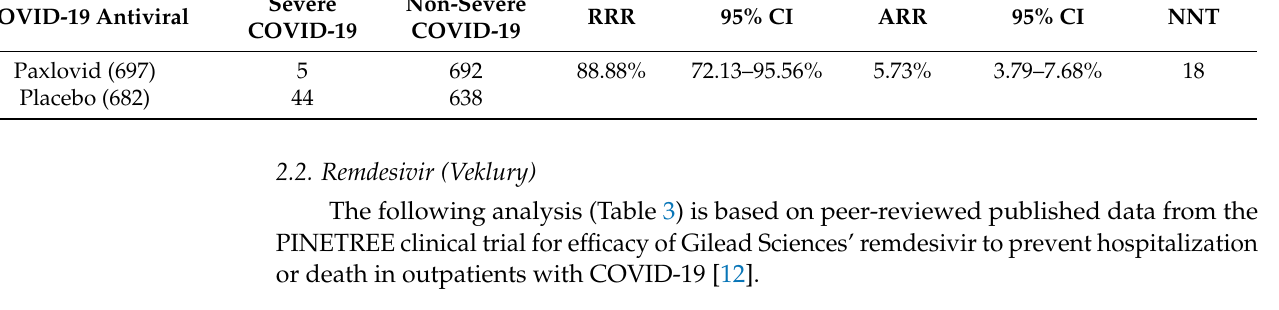
Table 3. Remdesivir (veklury) PINETREE trial data to prevent severe hospitalization or death in COVID-19 outpatients.